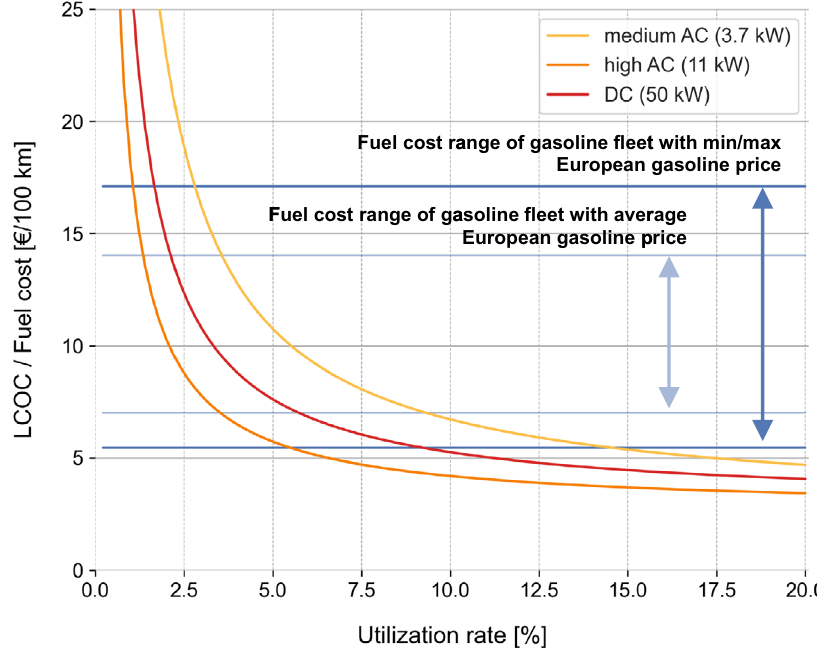
Fig.5|EuropeanaverageLCOCin € per100kmforthreecommercial,publicly accessible charging options dependent on the utilization rate of the infra- structure. The utilization rate on the x-axis describes the hypothetical share of timethatachargingstationisoperatingatnominalpower.Inrealityitseldomruns atfullycapacityandthustheshareoftimethestationisoccupiedishigher.Typical utilizationratesofutilizedinfrastructuretodayareroughly10 – 20%formediumAC charging, roughly 5 – 10% for high AC charging and roughly 1 – 5% for DC fast